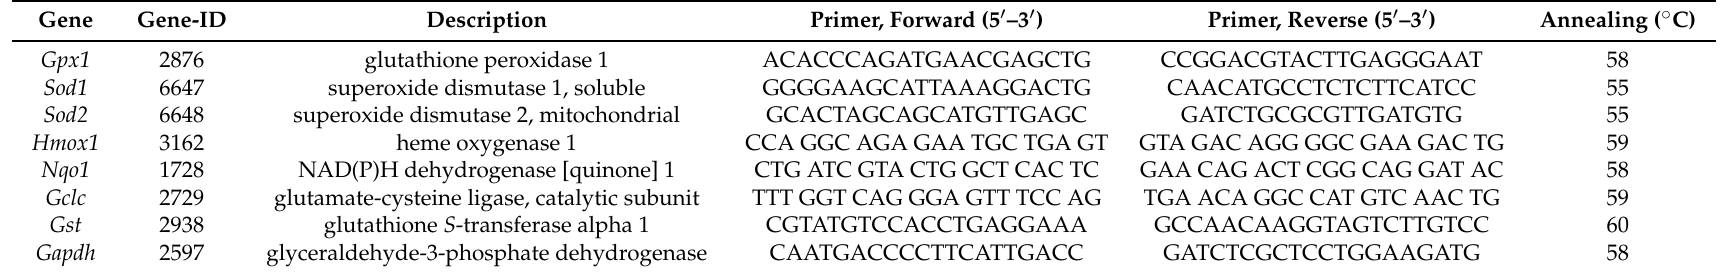
Table 2. Nucleotide sequences and annealing temperatures of primers used in qRT-PCR analyses in cultured Huh7